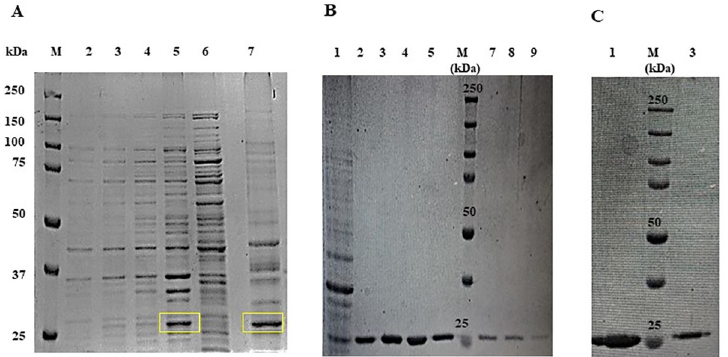
Fig 2. SDS PAGE analysis of recombinant Dermatopontin (rDPT) expressed in E . coli GJ1158 host as inclusion bodies and purified by affinity chromatography. (A) Lane 1: protein marker; Lane 2: protein lysate of host transformed with empty vector (pRSETA); Lane 3: induced host transformed with recombinant vector; Lane 4: soluble protein fractions obtained after homogenization of induced host cells transformed with recombinant vector; Lane 5: insoluble protein fractions obtained after homogenization of induced host cells transformed with recombinant vector; Lane 6: uninduced host transformed with recombinant vector; Lane 7: urea solubilized inclusion body fraction (B) Lane 1: Flow through from nickel activated Sepharose column; Lane 2,3,4,5,7,8,9: Purified refolded rDPT eluted at 150 mM imidazole concentration; Lane 6: protein marker (C) Lane 1 & 3: centricon concentrated rDPT elutes; Lane 2: protein